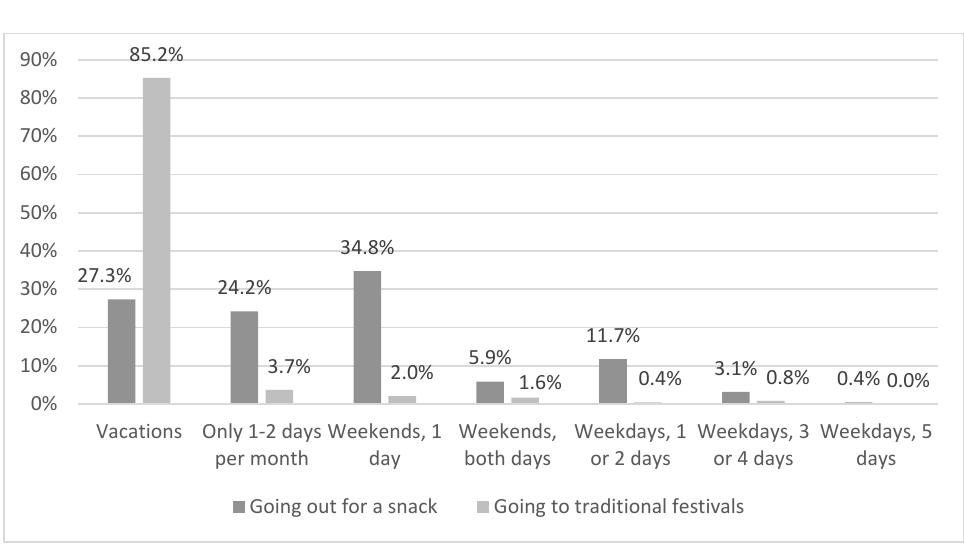
Figure 5. Frequency of shared festive leisure activities.